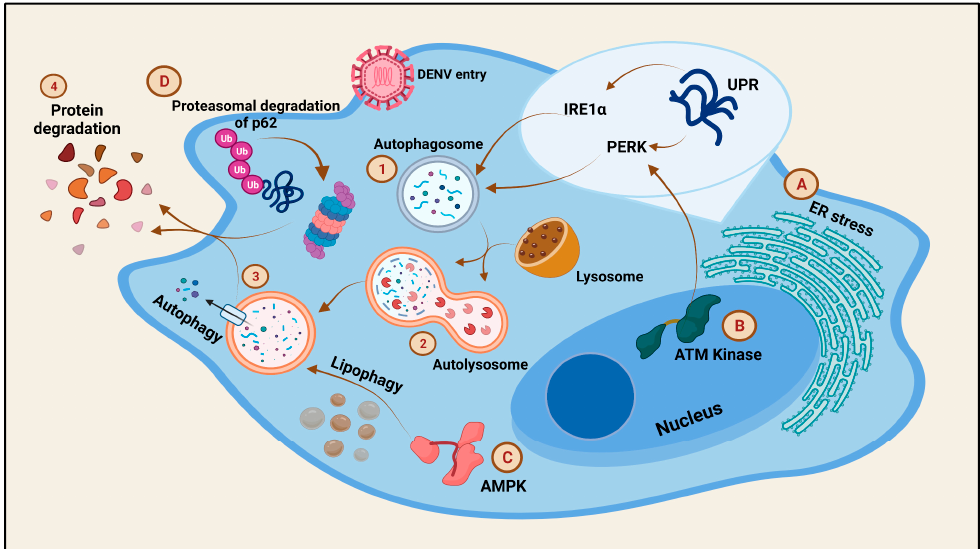
Figure 6. Regulation of cell death via autophagy during Dengue virus infection: The entry of Dengue virus induces autophagy in the infected cell. The mechanisms of autophagy post-DENV infection are: A. Induction of ER stress to trigger the UPR responses, out of which 2 pathways, involving IRE1 α and PERK, respectively, lead to the formation of autophagosomes in the cell. B. Autophagosome formation is also triggered by the involvement of ATM kinase to trigger the PERK pathway for autophagosome formation. C. AMPK, a kinase involved in lipophagy, is also exploited by the DENV to modulate the metabolic status of the cell. D. Apart from the common steps of autophagy, the DENV employs the proteasomal degradation of p62 to enhance its replication. The autophagosome in step 1 fuses with the lysosome to form the 2. Autolysosome structures which ultimately lead to 3. Autophagy and 4. Protein degradation.